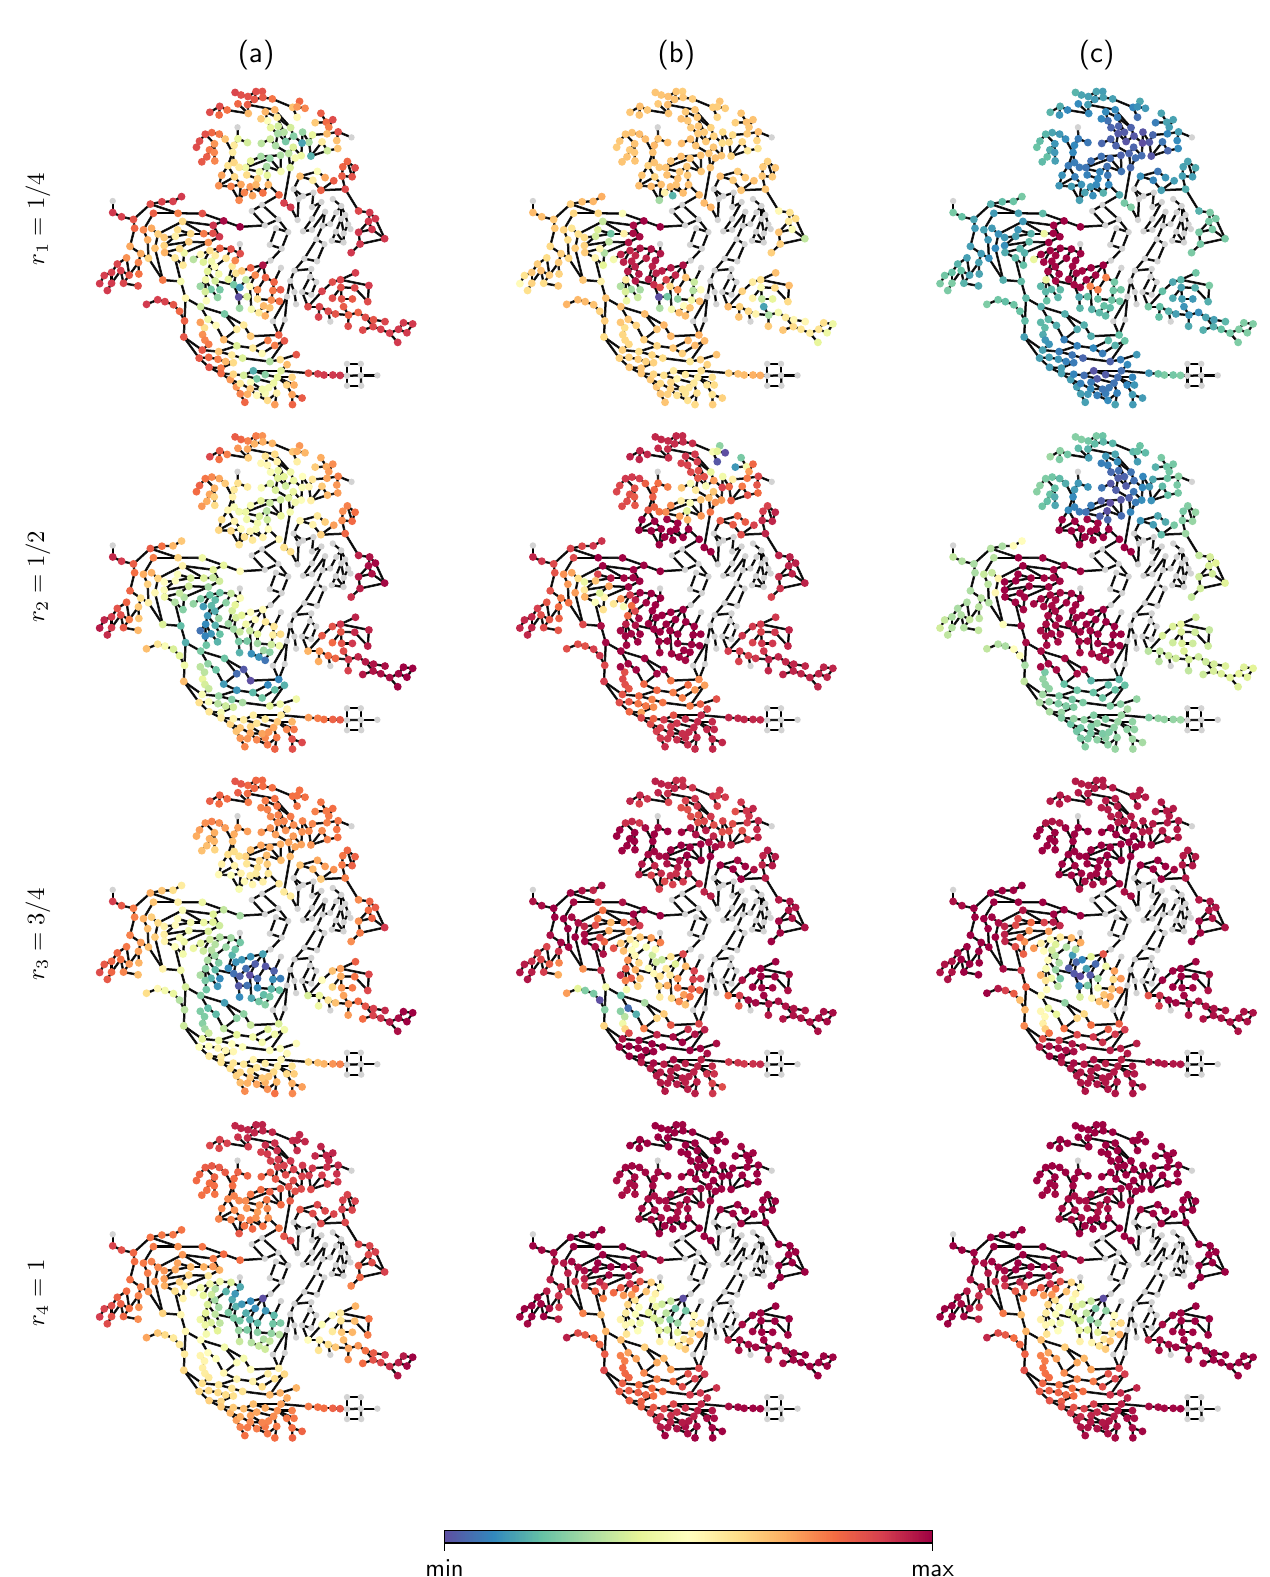
Figure 4. Mean resilience index ρ ( o ) for each node serving as the evacuation origin for all analyzed evacuation radii and sheltering schemes. ( a ) centralized sheltering ( b ) near-at-hand sheltering ( c ) diffuse